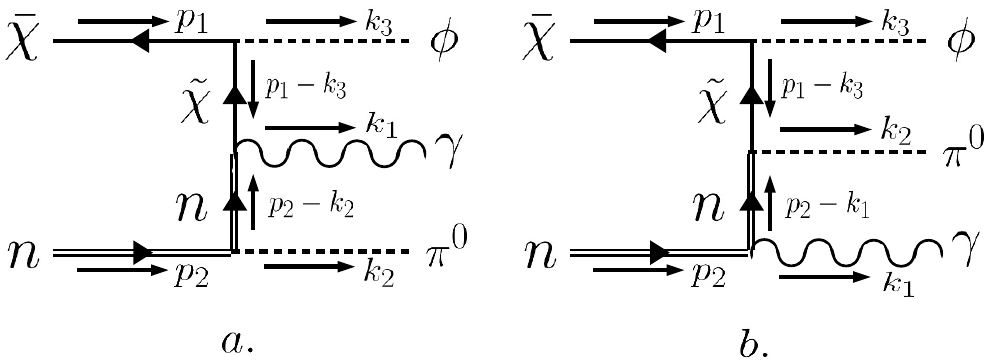
Figure 2 . Feynman diagrams for ¯ χ + n